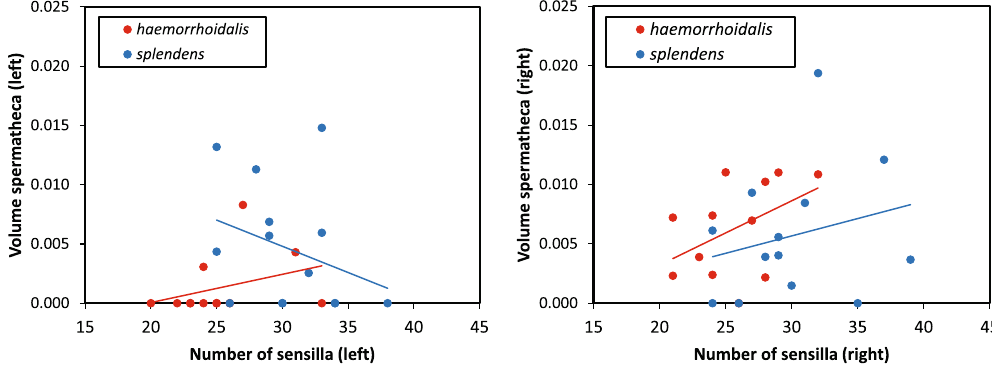
Figure 5. The relationship between the number of sensilla on the vaginal plates of female C. haemorrhoidalis and C. splendens and the volume of sperm (mm 3 ) in the spermatheca of females whose second copulation was interrupted after 60–120 movements of stage I (N = 28 females). Note the different patterns between sides, the left spermatheca being emptied more frequently. On the left spermatheca, the effect of female species was significant. On the right spermatheca, the only significant (positive) effect was the number of sensilla. The species identity of the male had no significant effect in any